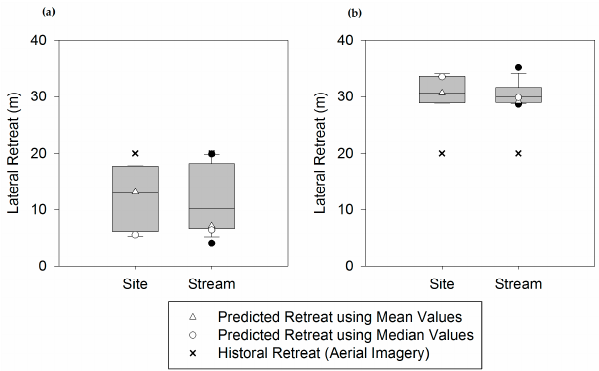
Figure 7. Boxplots of variation in CONCEPTS predicted lateral retreat at a site on Barren Fork Creek using JET results from the site and entire stream reach for: ( a ) excess shear stress model; and ( b ) Wilson model.